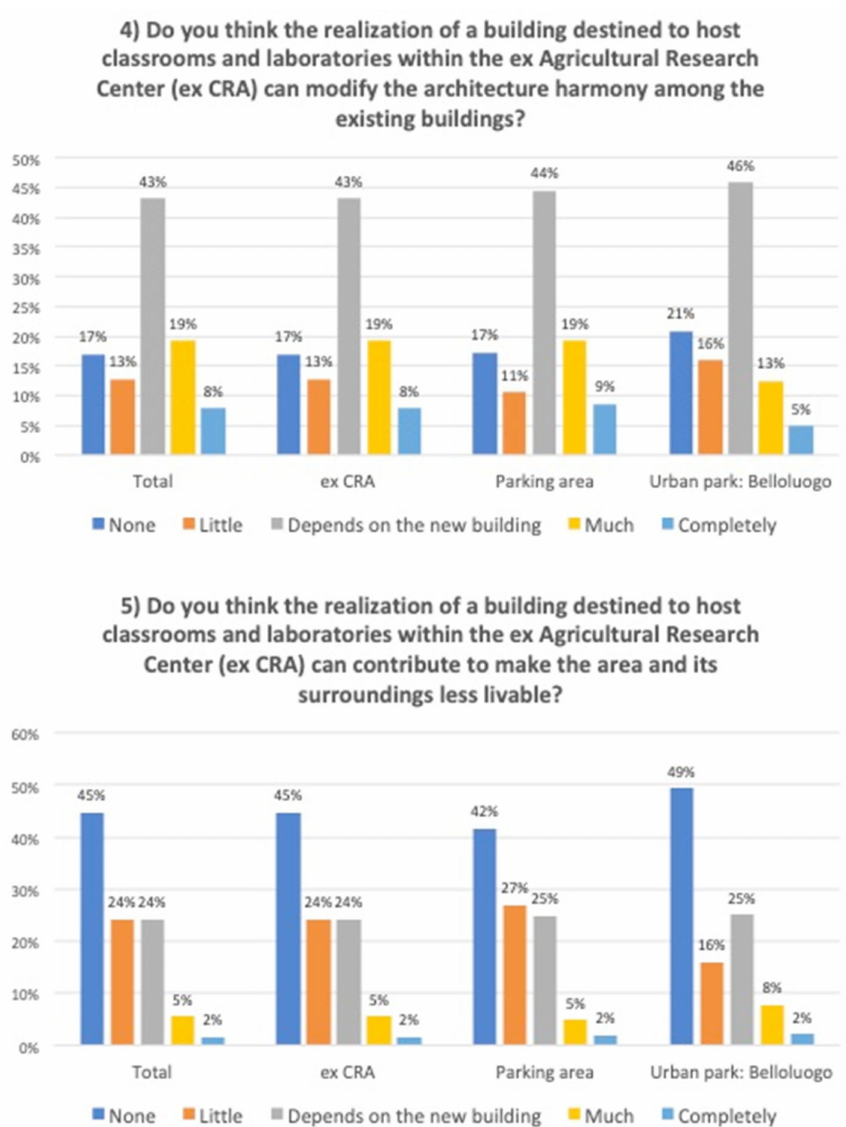
Figure 6. Answers to questions on the possibility of a new building inside the former CRA. According to the surveyed respondents, the width and height of a new building could also be the same as the size of the central building existing within the former CRA, or even wider and higher. In fact, these two options were the second most selected choices in all the three sampling areas (Figure